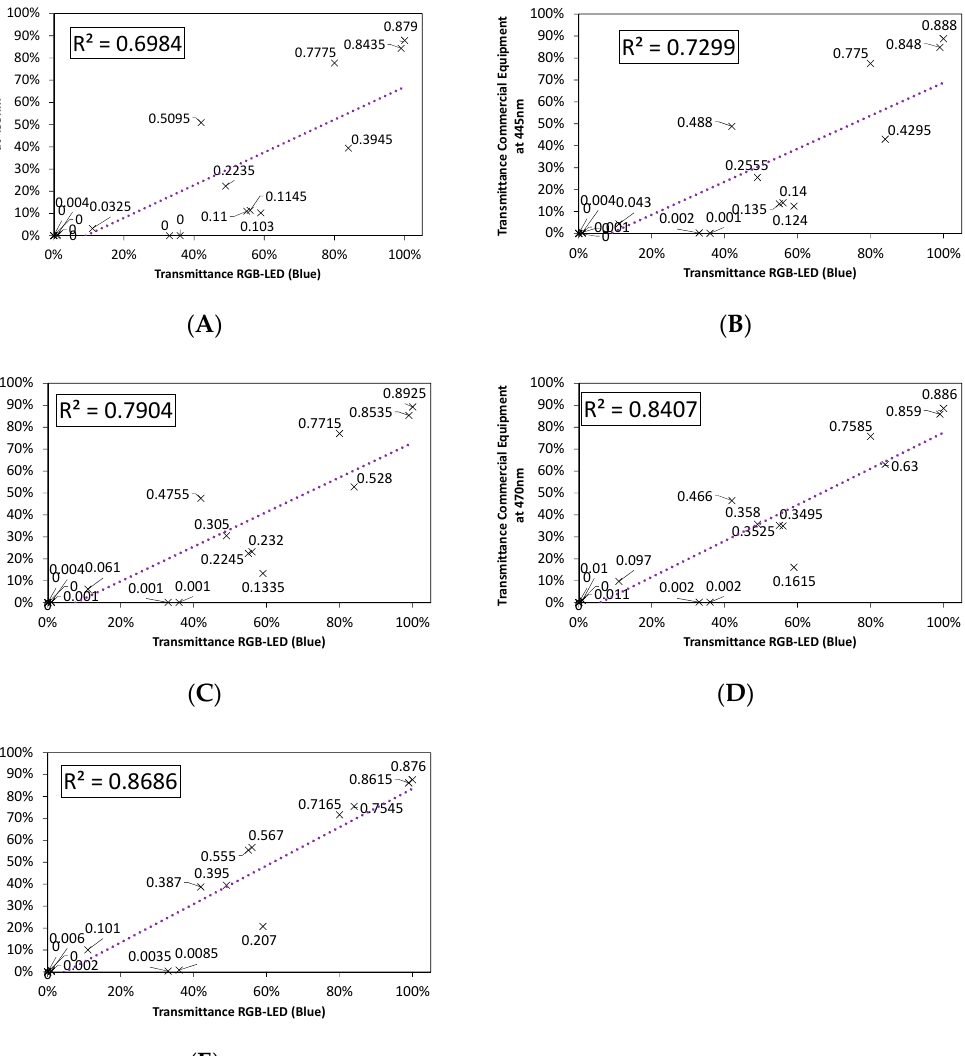
Figure 9. Comparison of the fit for the emission spectrum of the green LED to: ( A ) 500 nm, ( B ) 510, ( C ) 525 nm- λ Peak, ( D ) 530 nm, and ( E ) 550 nm.